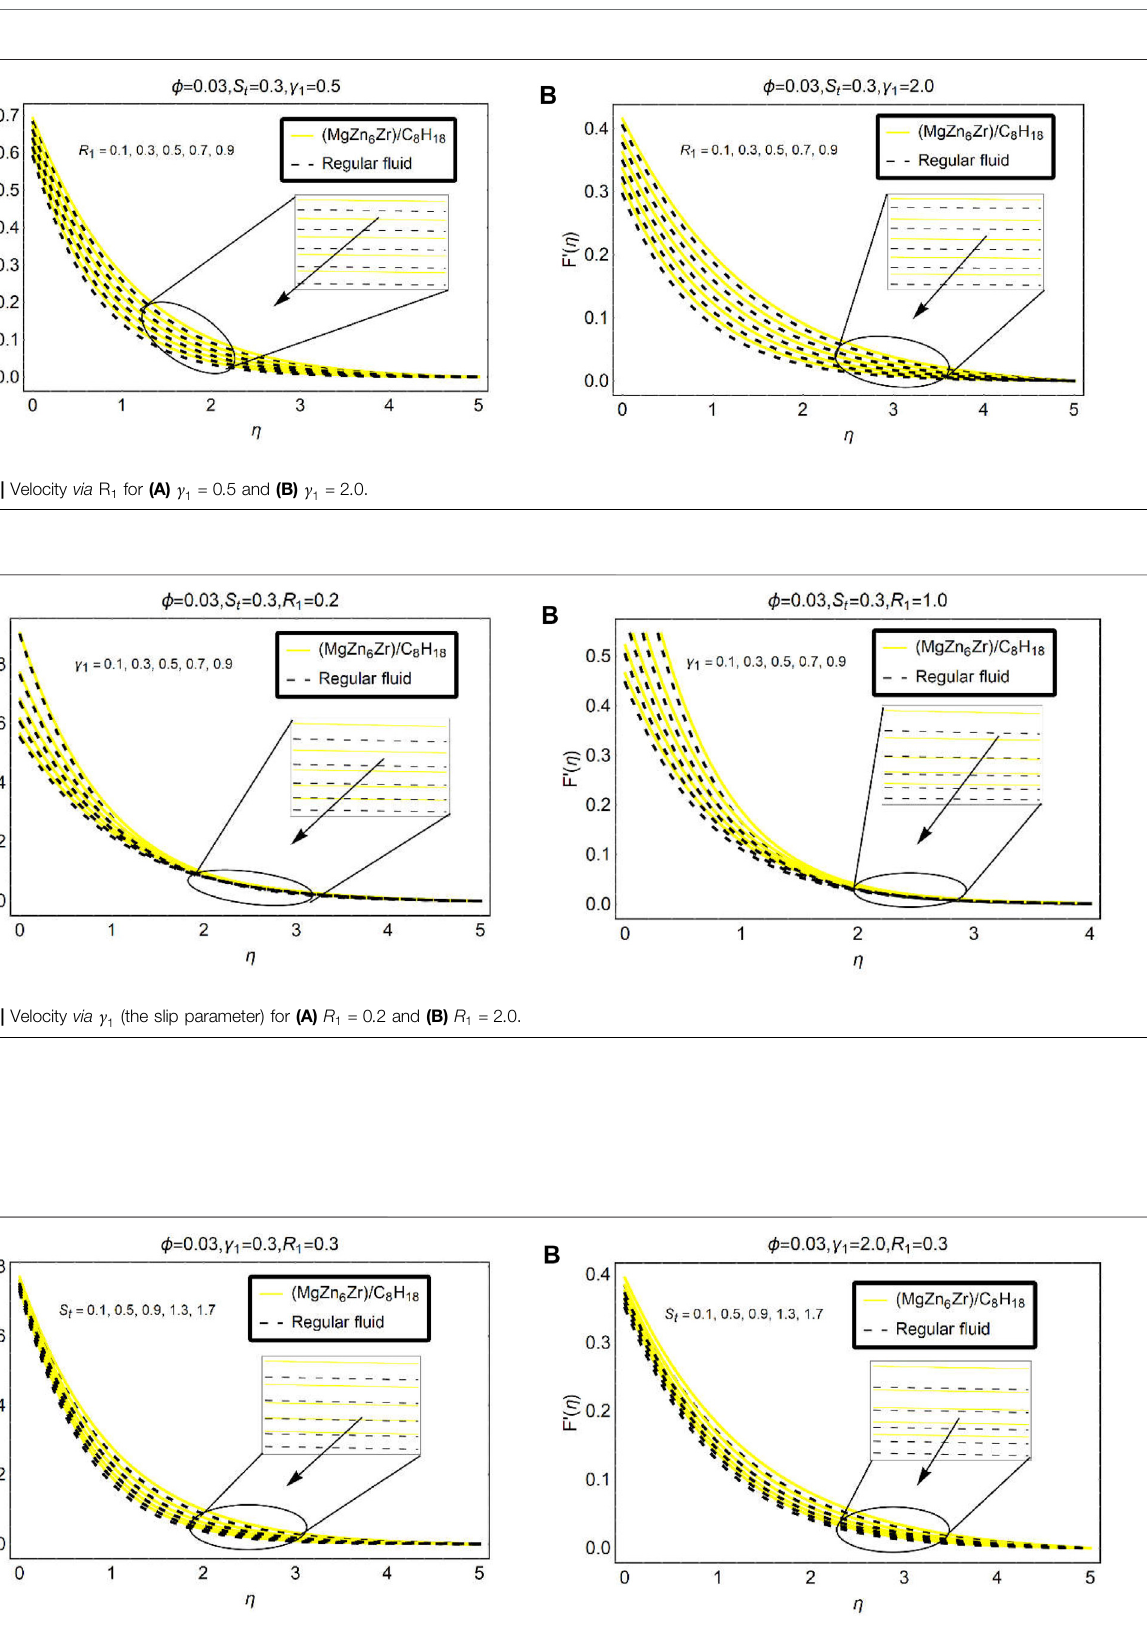
FIGURE 5 | Velocity via S t (the stretching parameter) for (A) γ 1 (cid:2) 0 . 3 and (B) γ 1 (cid:2) 2 . 0.